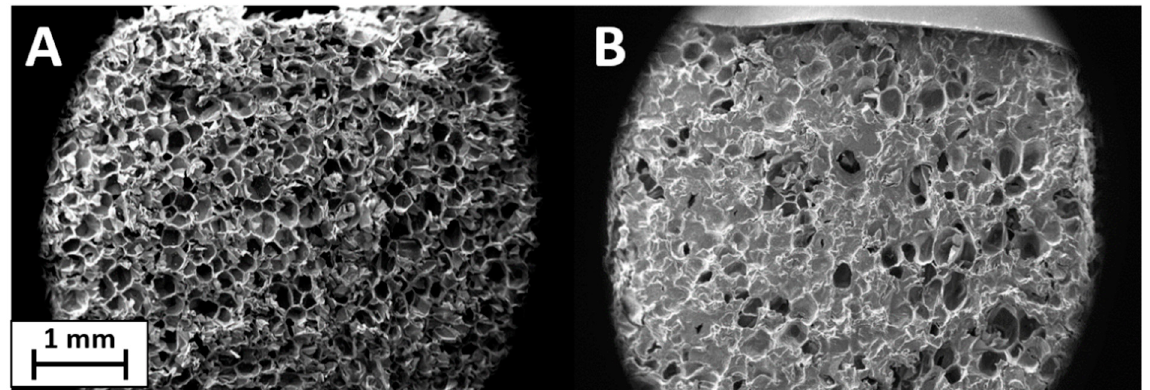
Figure 3. SEM images of untreated polyethylene terephthalate (PET) foam ( A ) and PET foam treated with PSS/GNPs coating ( B ).